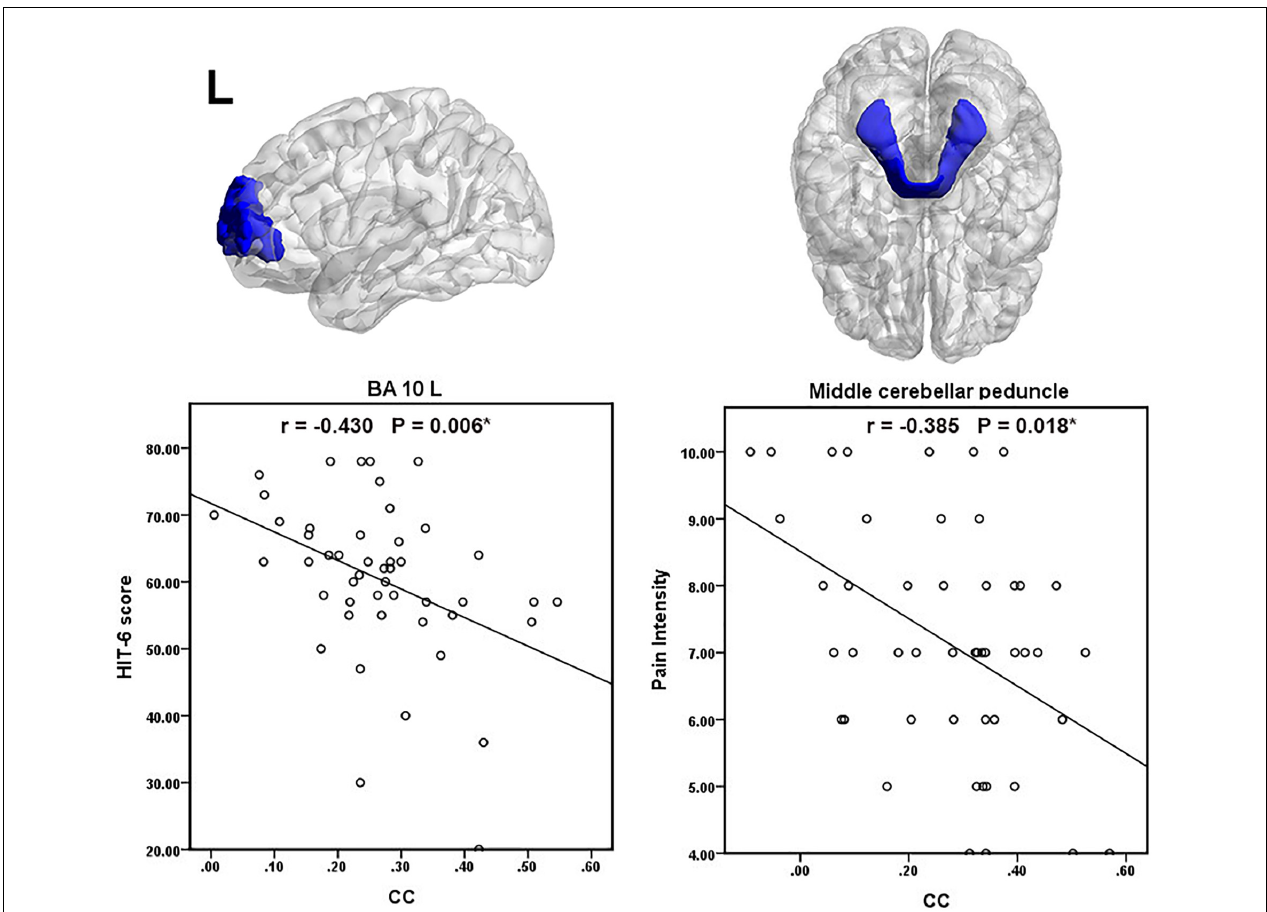
FIGURE 4 | Scatter plot of significant clinical correlations. The (*) denote p (FDR adjusted) <